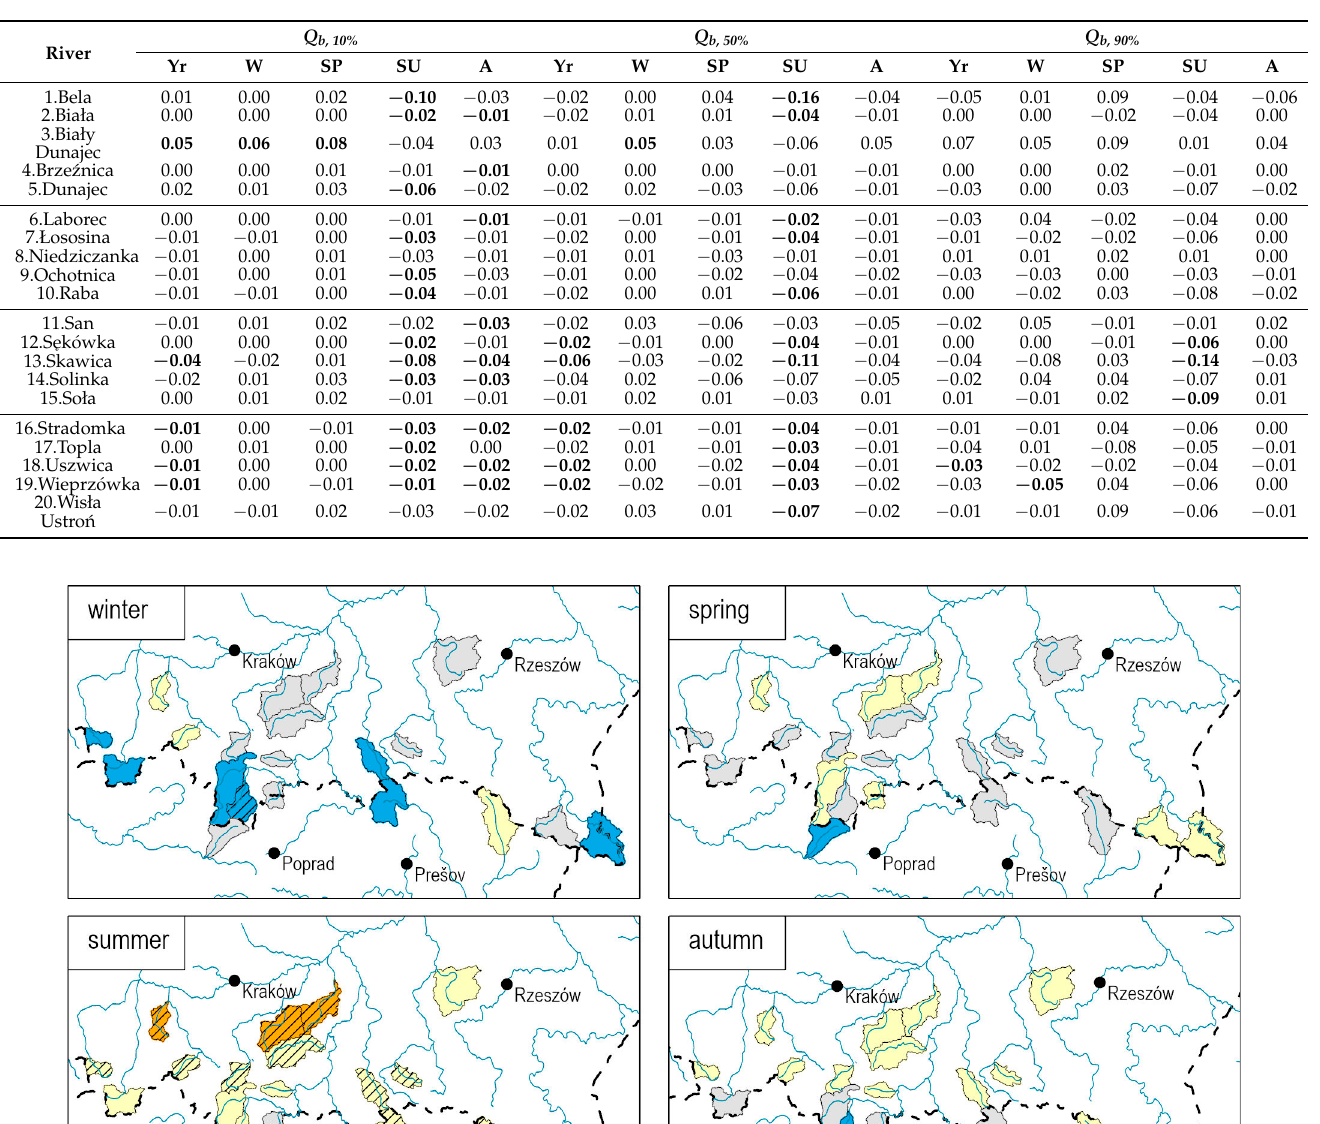
Table 3. Theil–Sen estimator (mm/10 years) for daily baseflow ( Q b ) percentiles obtained for the entire year (Yr), winter (W), spring (SP), summer (SU), and autumn (A); statistically significant trends are marked in bold.